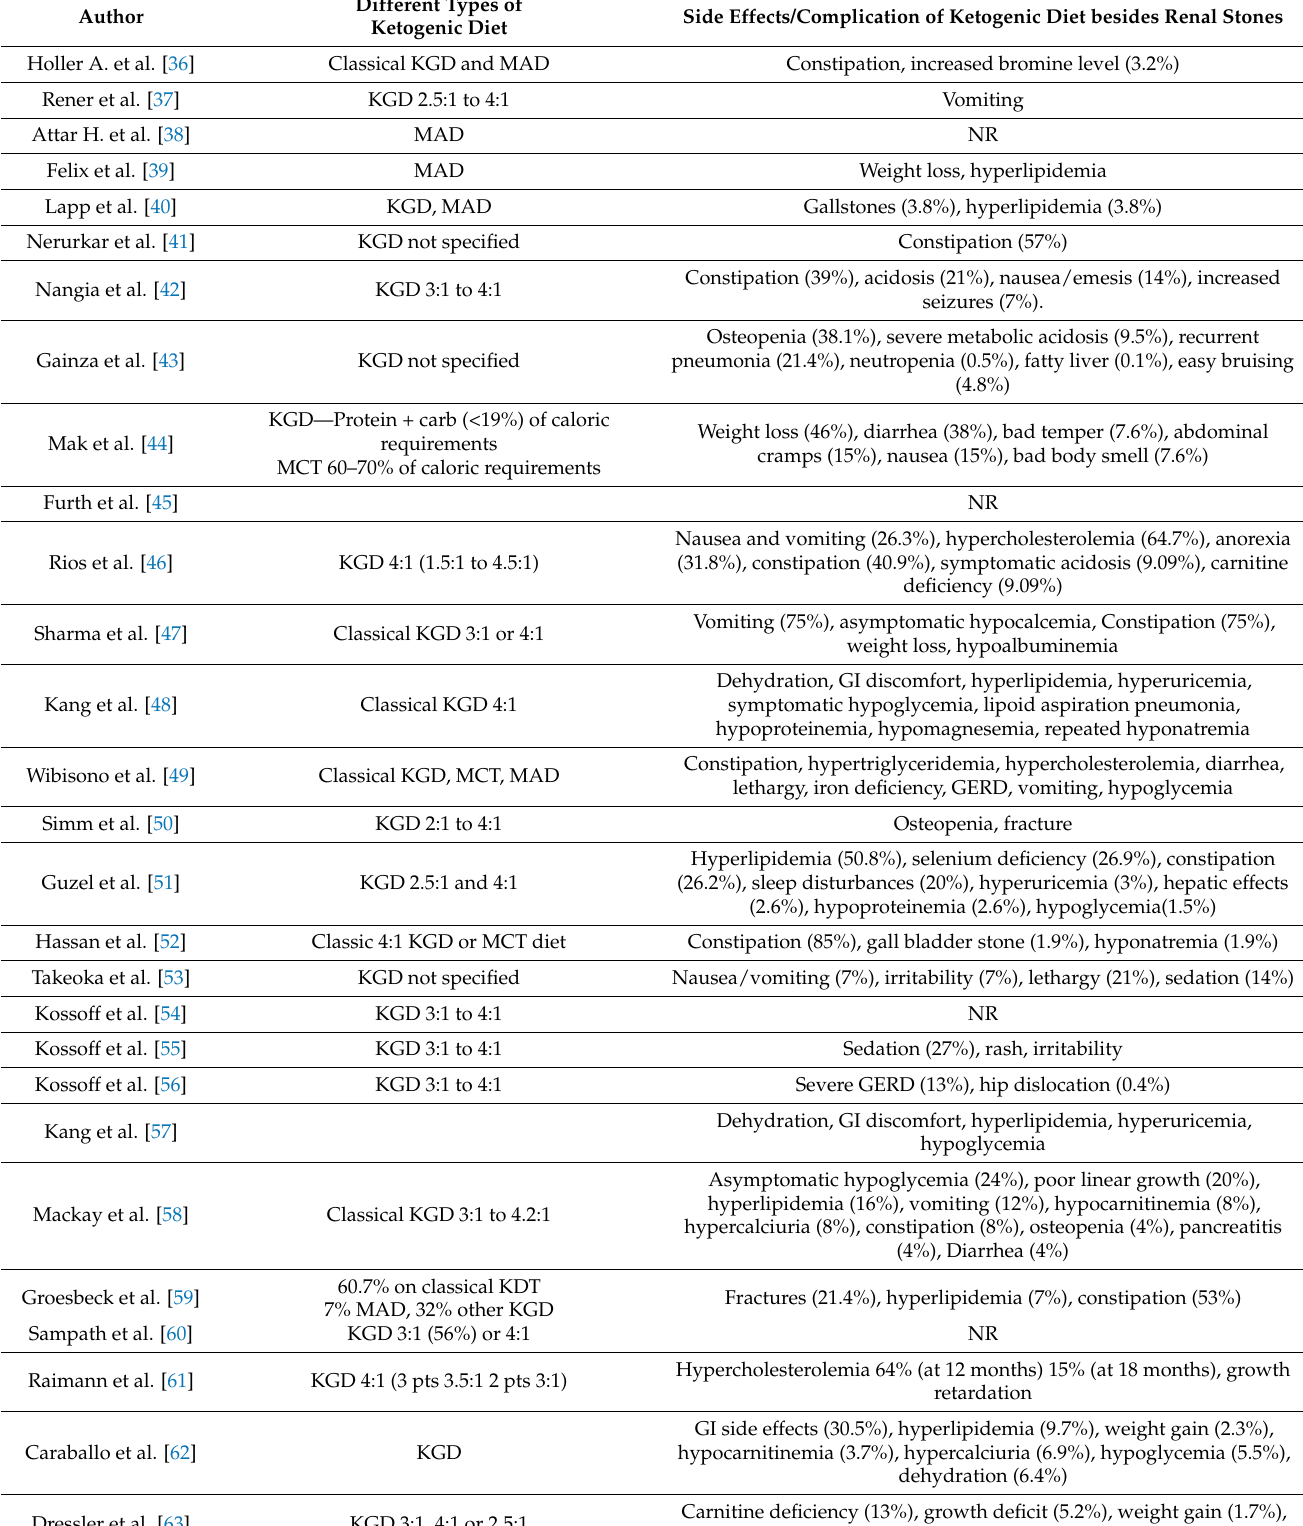
Table 2. Definitions and reported adverse effects observed in ketogenic diets in different